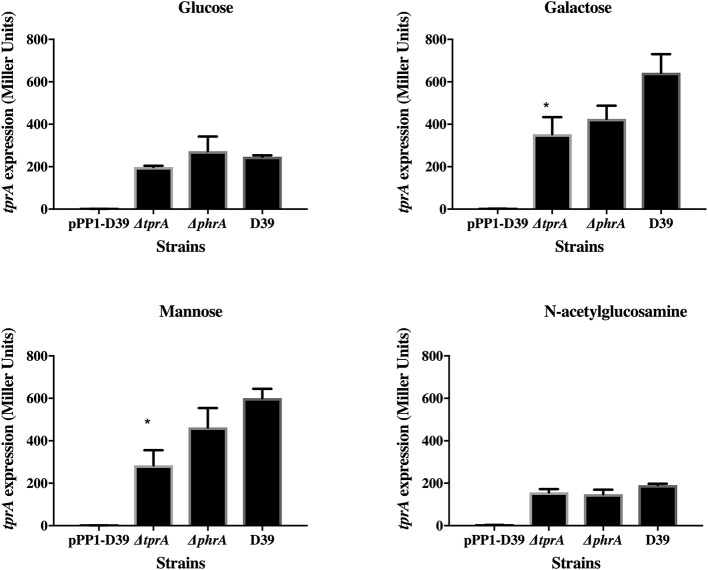
Analysis of tprA regulation in different sugars using a LacZ reporter assay. The activity of ß-glactosidase under regulation of PtprA is expressed in nmol p-nitrophenol/min/mL (Miller Units). A strain containing promoterless pPP1 plasmid (pPP1-D39) was included as a control in the assay. Values are average of three independent experiments each with three replicates. Bars indicate standard error of mean (SEM). *
p < 0.05.